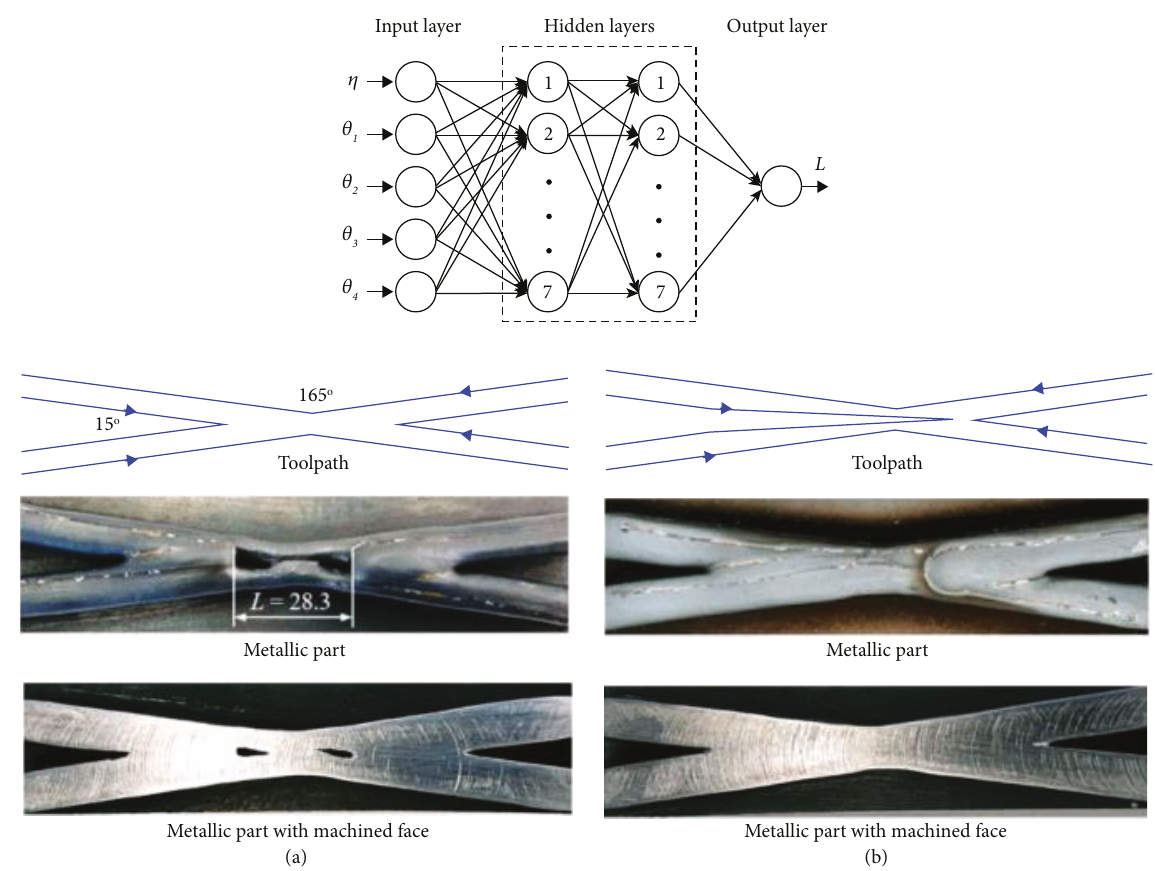
Figure 27: Schematic architecture of the ANN. Performance of an example: (a) tool path pattern without correction; (b) tool path pattern with correction.